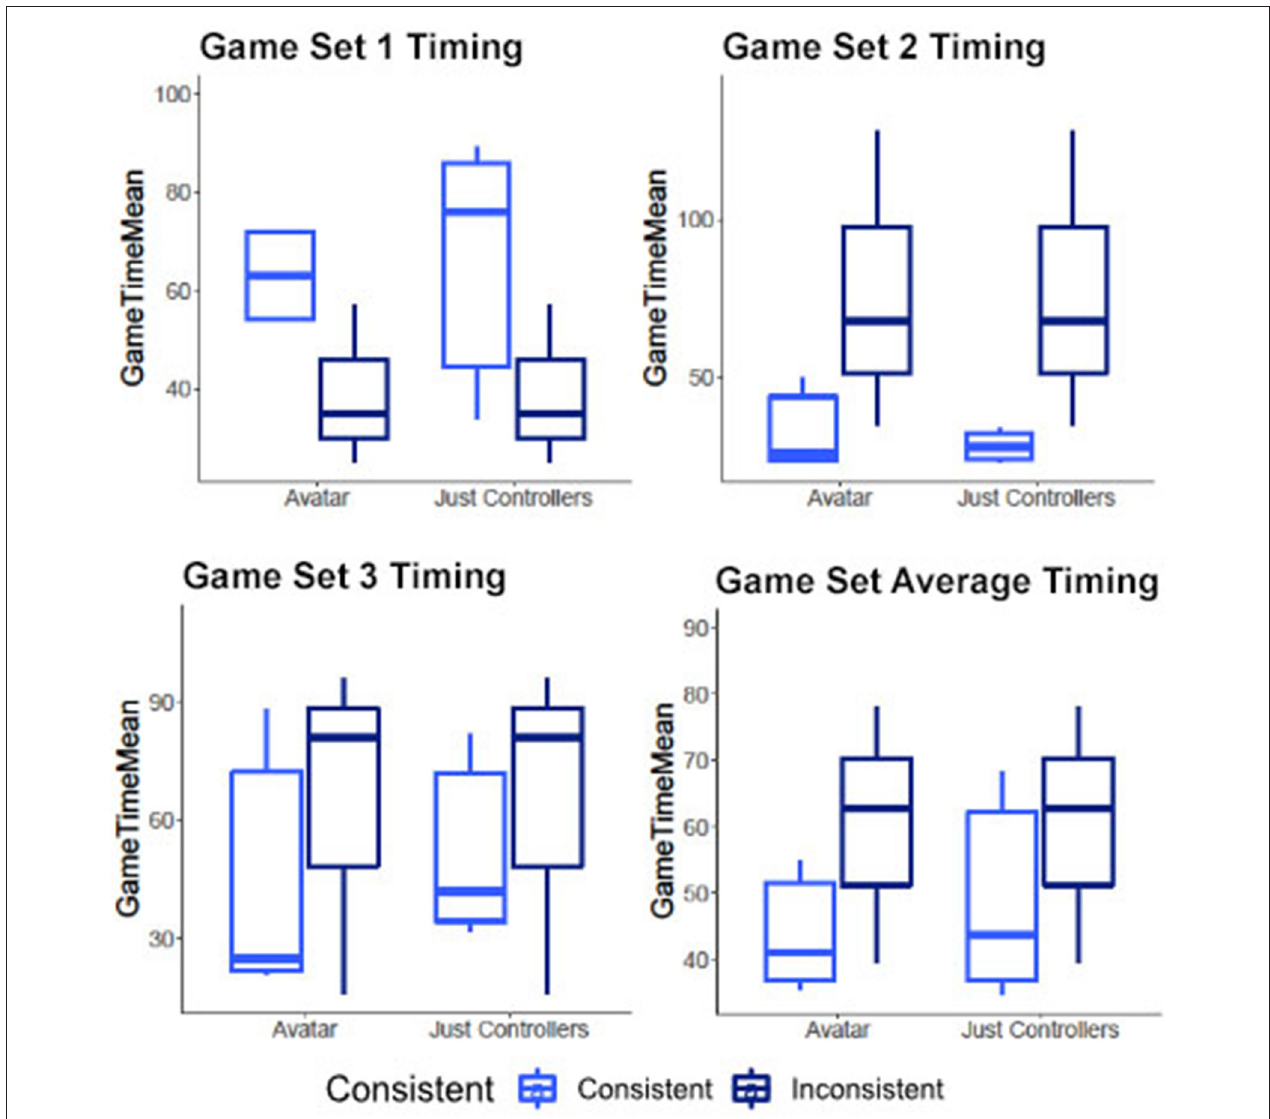
FIGURE 7 | Study 2: boxplots of “Build the Block” game set